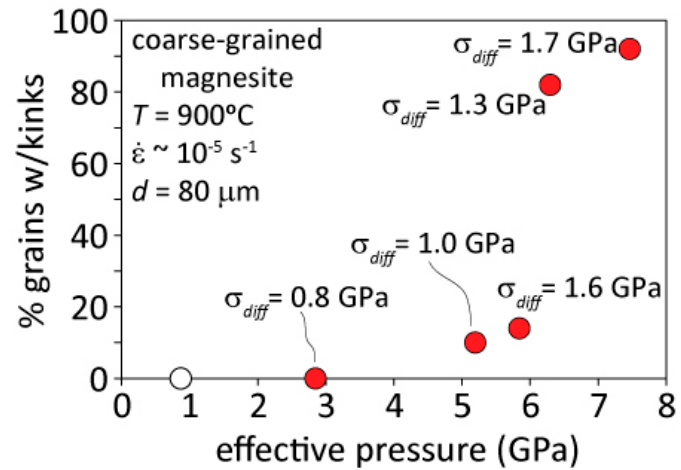
Figure 9. Kinking is not observed in coarse-grained magnesite deformed at P eff < 3 GPa, but the percentage of grains with kinks increases slightly with increasing pressure from P eff = 3 to P eff ~ 6 GPa and dramatically increases at P eff > 6 GPa (red points, this study, D-DIA; open circle, [17], Griggs apparatus).